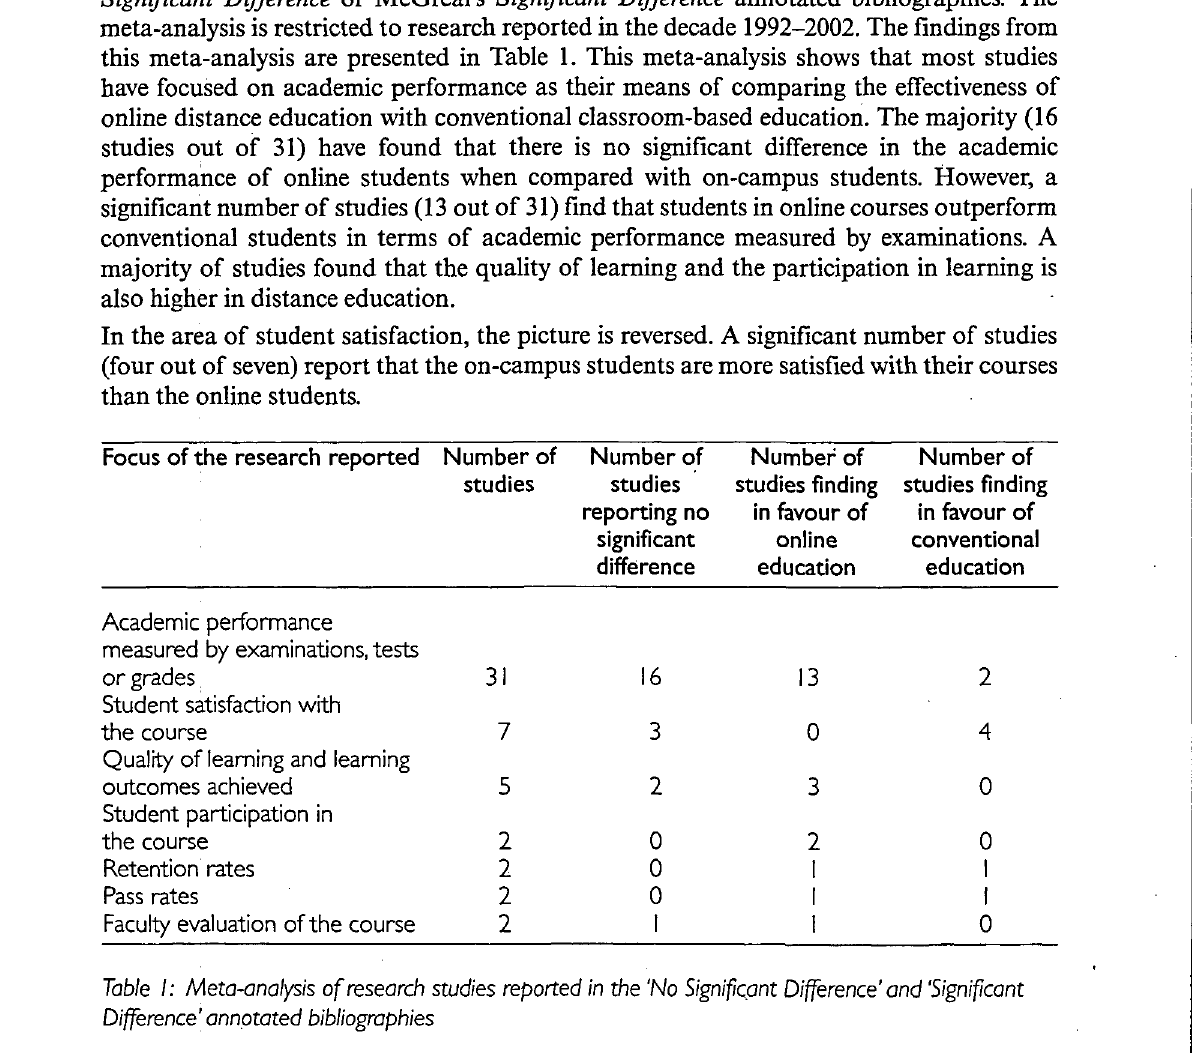
Table I: Meta-analysis of research studies reported in the 'No Significant Difference' and 'Significant Difference' annotated